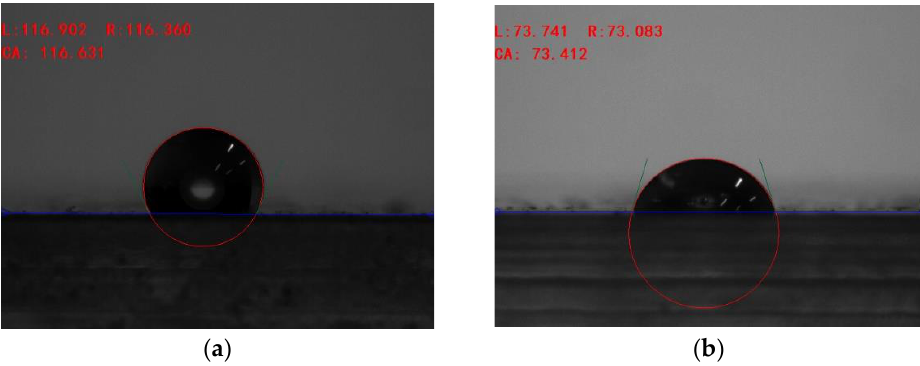
Figure A1. ( a ) The surface interaction in the case of a hydrophobic PMMA surface with deionized water; ( b ) the surface interaction in the case of a hydrophobic PMMA surface with mineral oil.